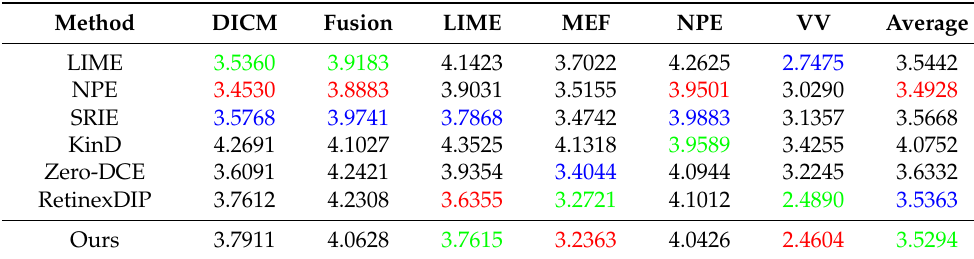
Table 1. Comparison of average NIQE on six datasets. (The red, green, and blue scores represent the top three in the corresponding dataset, respectively).